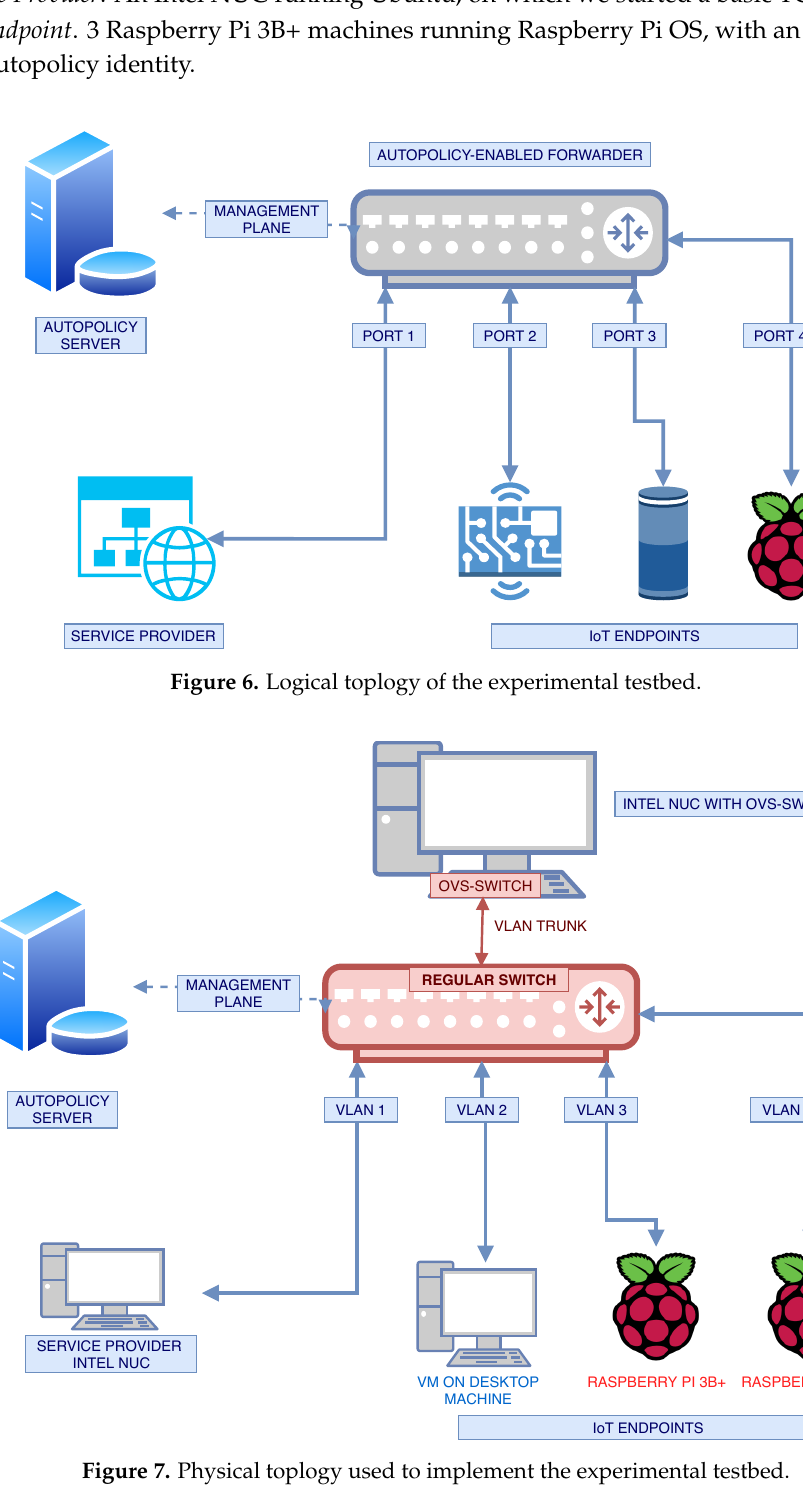
Figure 7. Physical toplogy used to implement the experimental